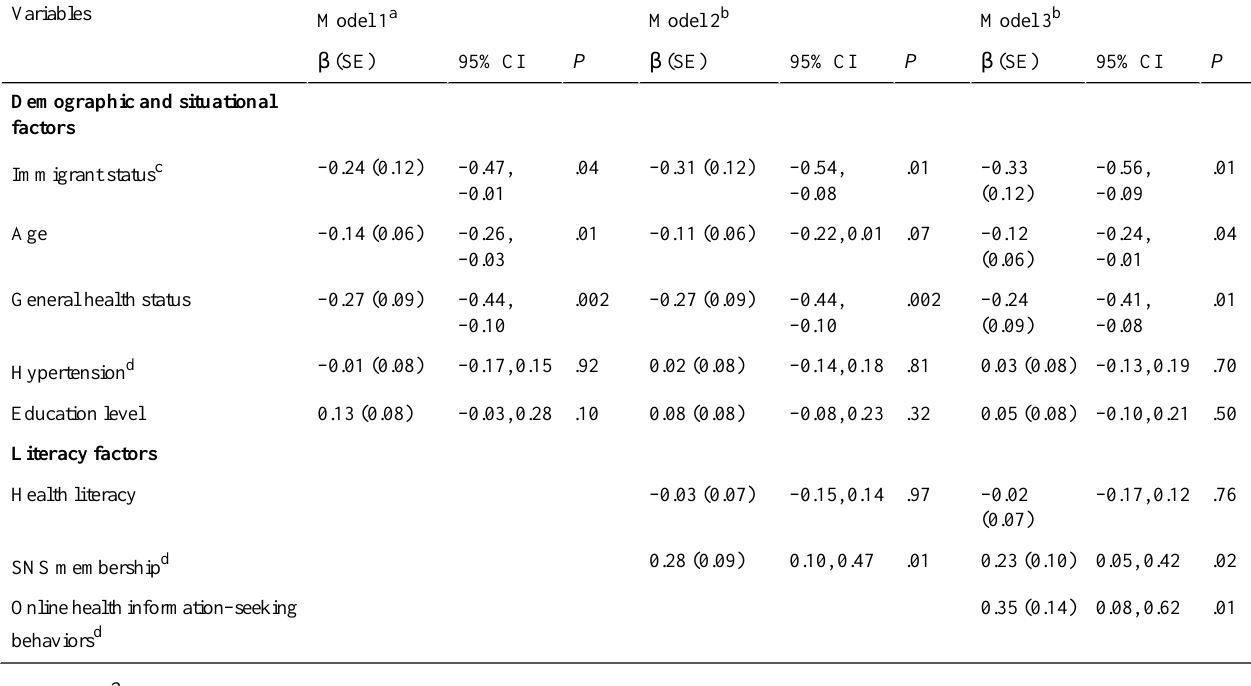
Table 3. Linear regression: association between online health information–seeking behaviors and fruit